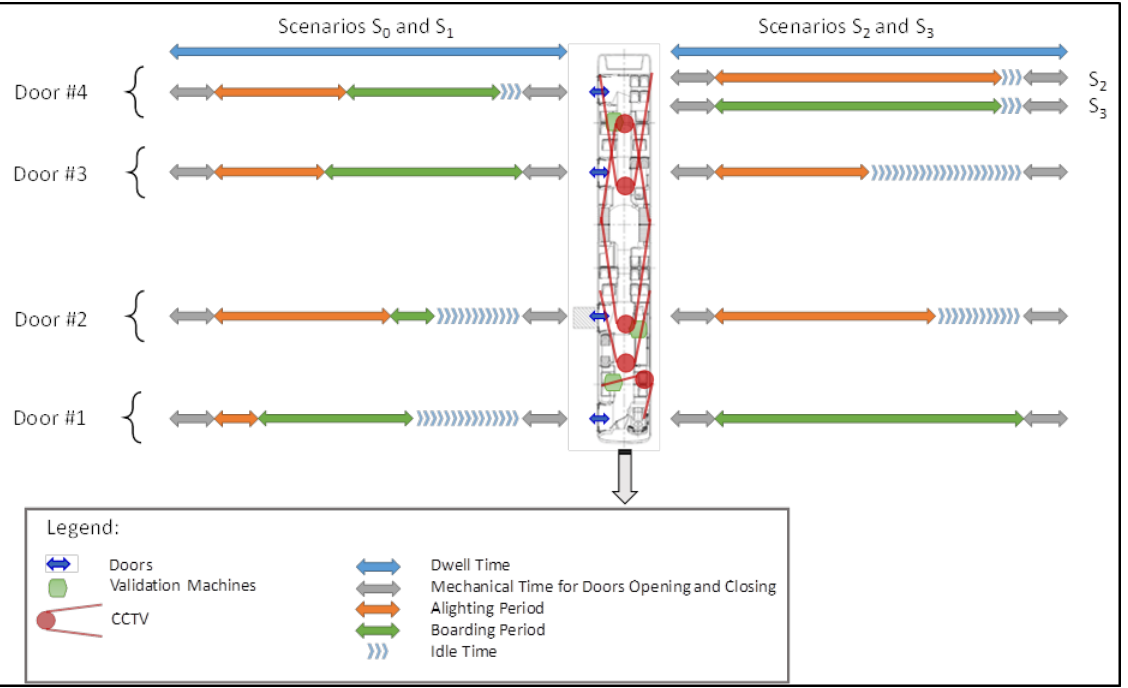
Figure 2. Position of doors, CCTVs and validation machines on board and composition of Dwell Time for each